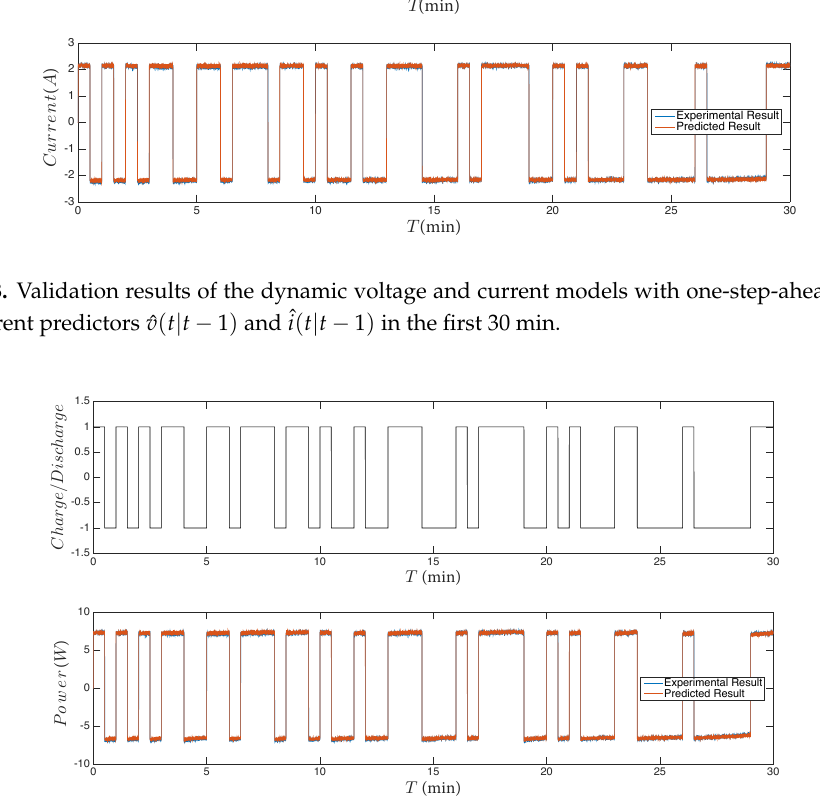
Figure 9. Validation results of dynamic power storage/delivery models with the one-step-ahead power predictor ˆ p ( t | t − 1 ) in the first 30